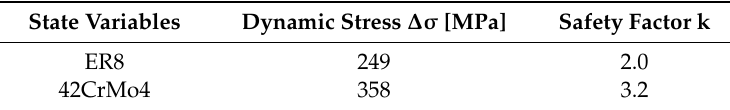
Table 7. State variables for best optimization result.